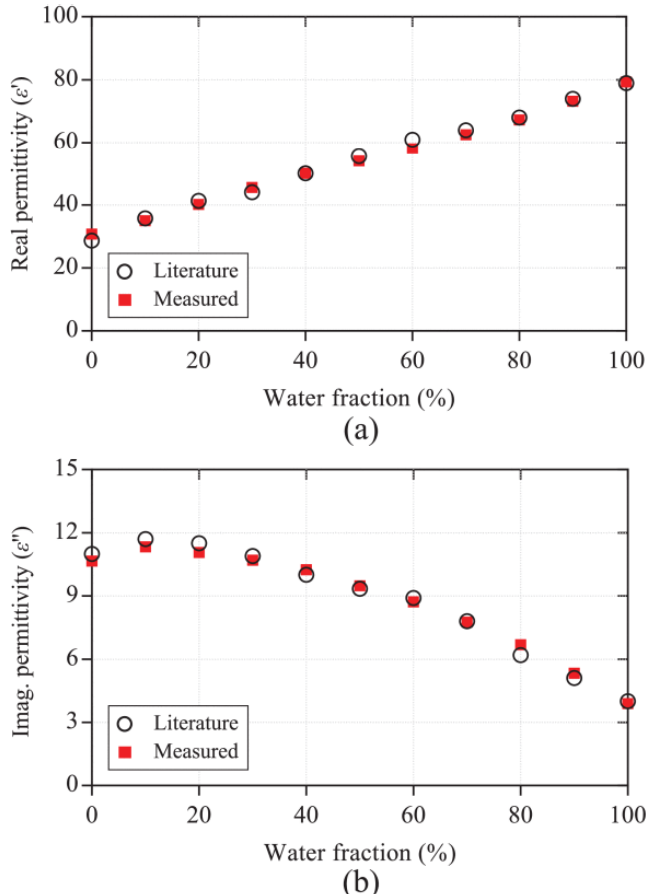
Figure 11. Real ( a ) and imaginary ( b ) part of the complex dielectric constant of water–methanol solutions as a function of the water content, inferred from the data of Figure 10 and the mathematical model developed in [46]. From [46], reprinted with permission.